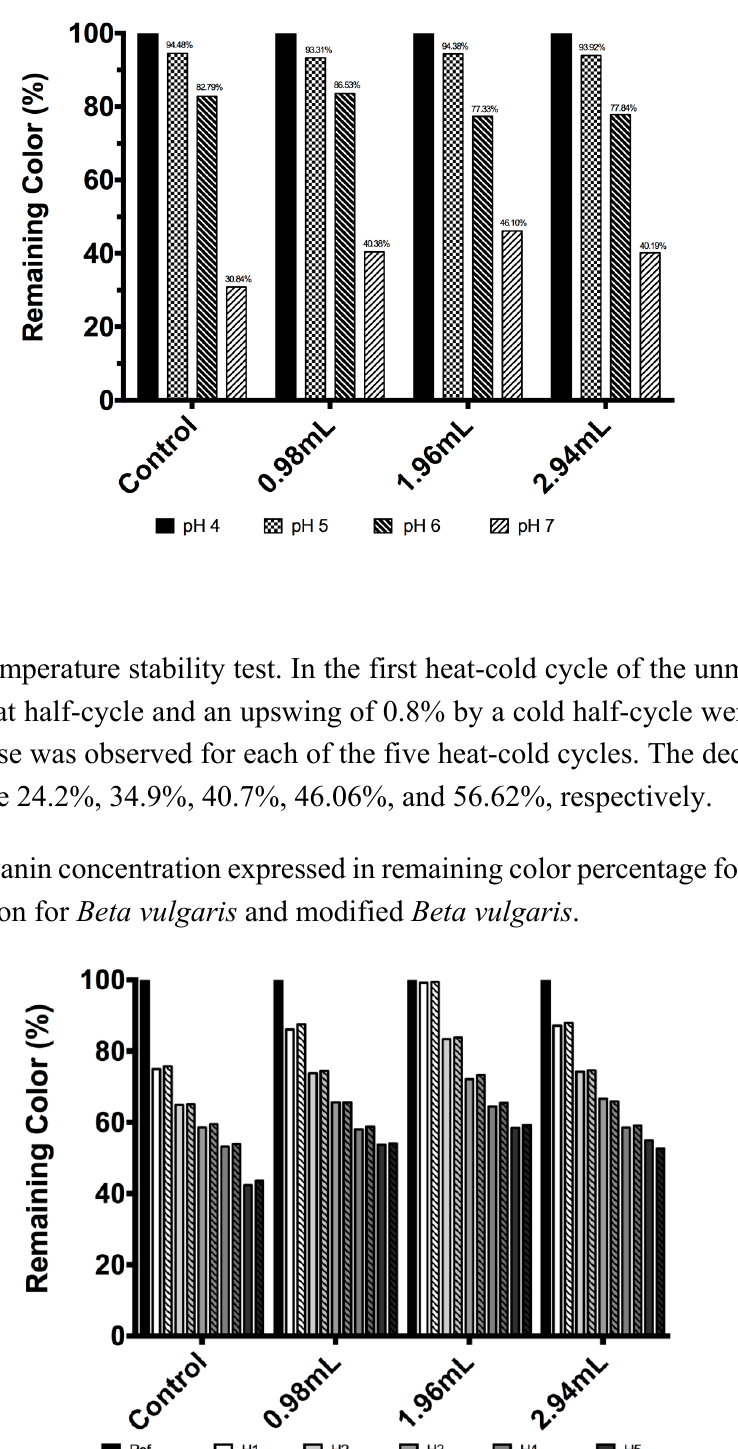
Figure 2. Betacyanin concentration expressed in remaining color percentage for Beta vulgaris and modified Beta vulgaris at different pH values.